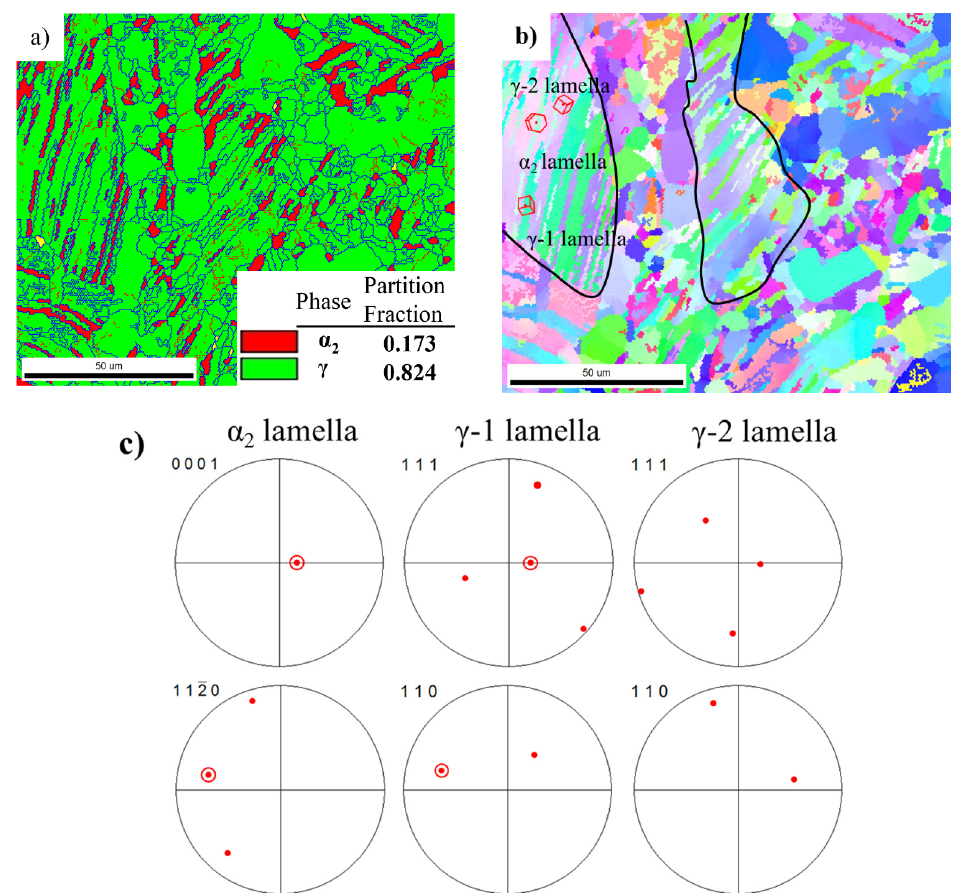
Figure 1. EBSD analysis of as-forged Ti-44Al-8Nb-(W, B, Y) alloy: ( a ) phase map, ( b ) orientation map and ( c ) pole figures of α 2 lamella, γ -1 lamella, and γ -2 lamella.